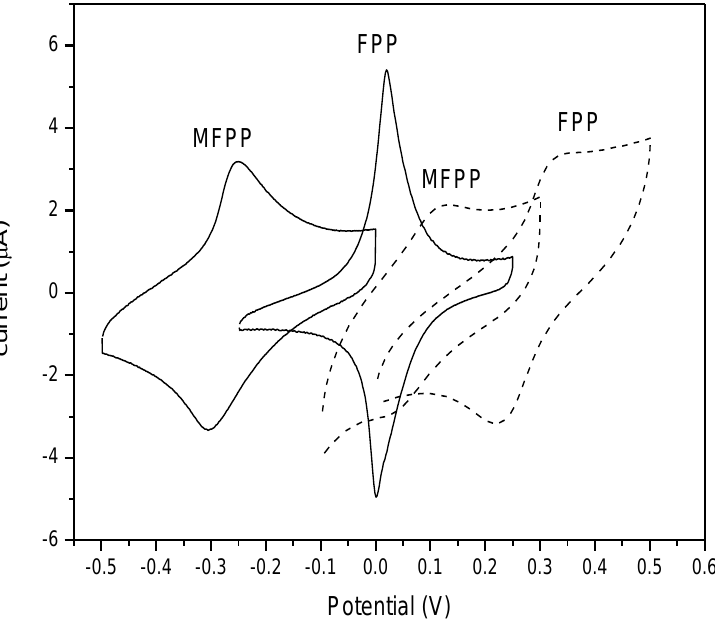
Figure 1. Cyclic voltammograms of Pt electrodes modified with MFPP and FPP ( Γ ∼ = 3 × 10 − 10 mol Fc cm −2 ) in non-aqueous (TBAH 0.1 M/acetonitrile) and aqueous (phosphate buffer pH 7.0 0.01 M/NaClO 4 0.1 M) (dashed lines) media at scan rate 100 mV s −1 .